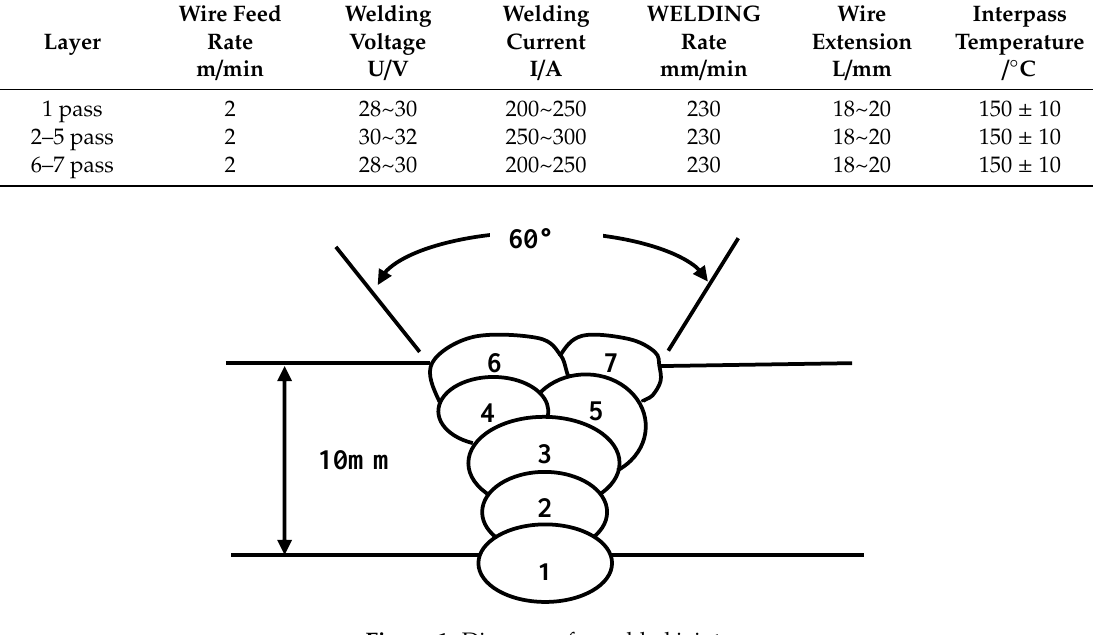
Figure 1. Diagram of a welded joint. Table 6. Welding process parameters.